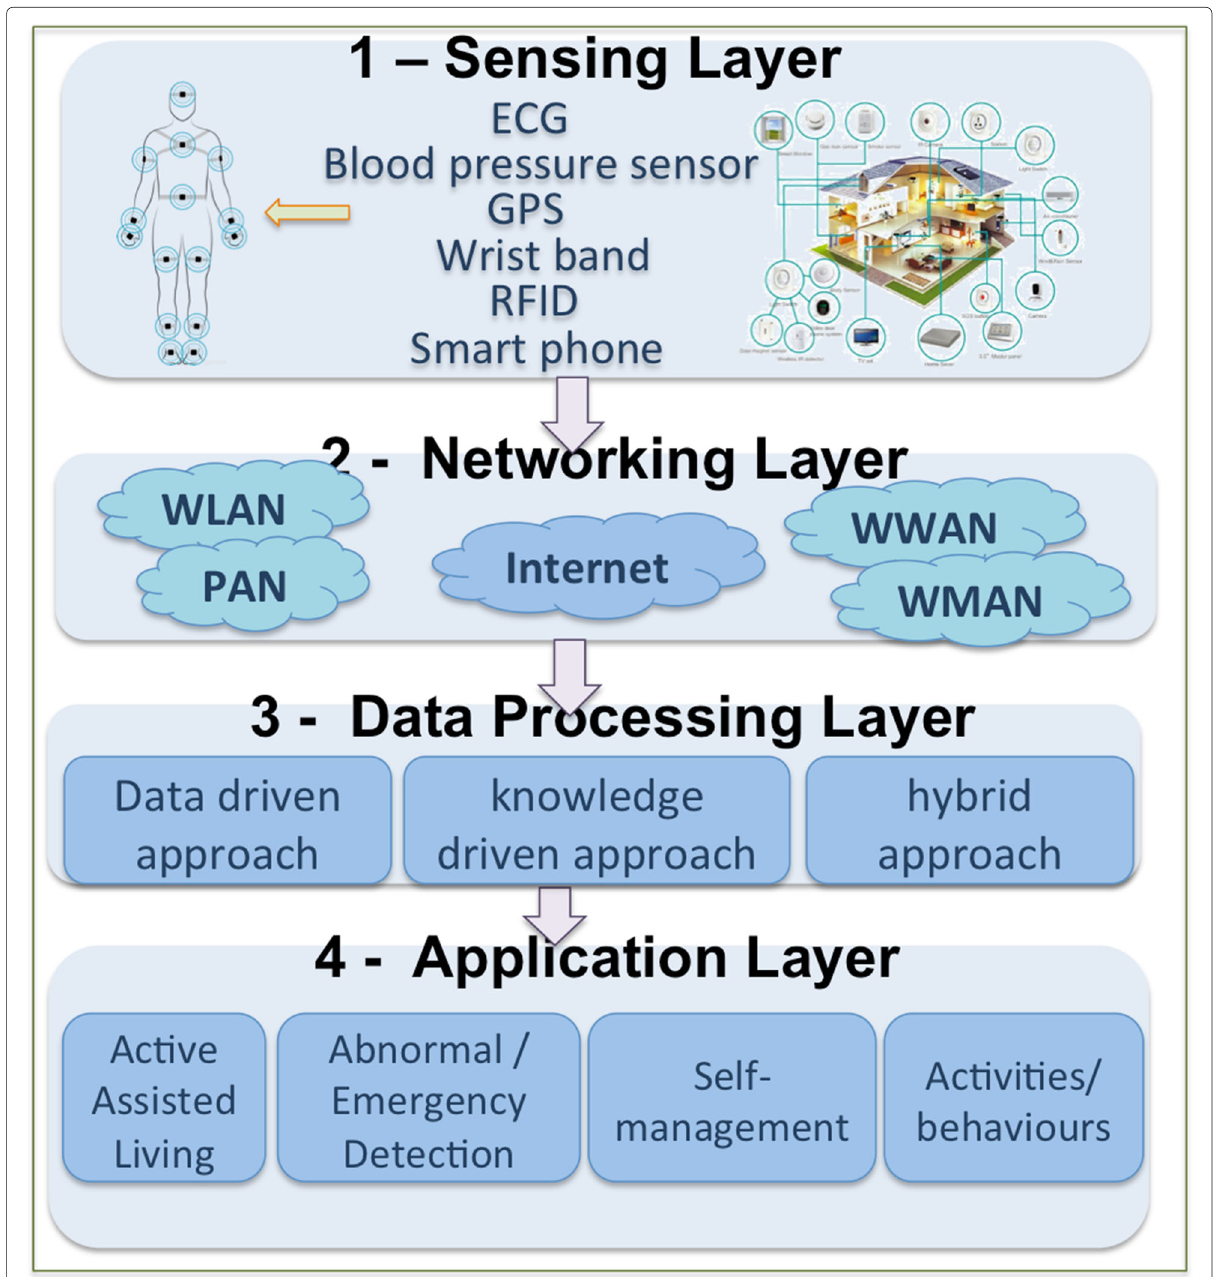
Fig. 1 IoT for healthcare: a overall framework of embedding IOT technologies for personalised